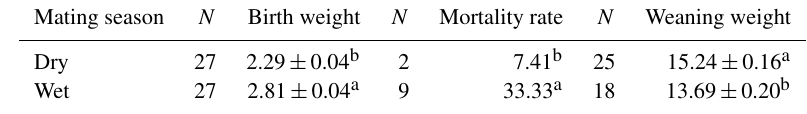
Table 5. Effect of dry and wet seasons on birth and weaning weight and mortality rate of Abou-Delik lambs (LSM ± SE). Mating season N Birth weight N Mortality rate N